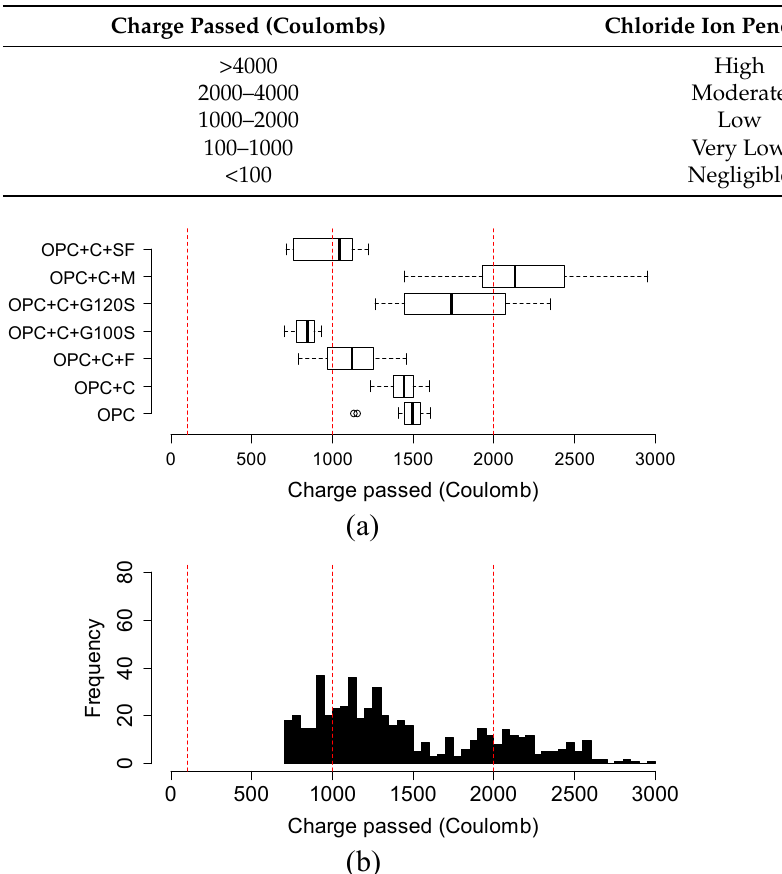
Figure 9. ( a ) Variation and ( b ) distribution of charge passed of Class C fly ash-based mixtures at 91 days. Three vertical red lines in the box plot represent the range of negligible, very low, and low permeability chloride ion permeability class as classified by ASTM C1202 specification.